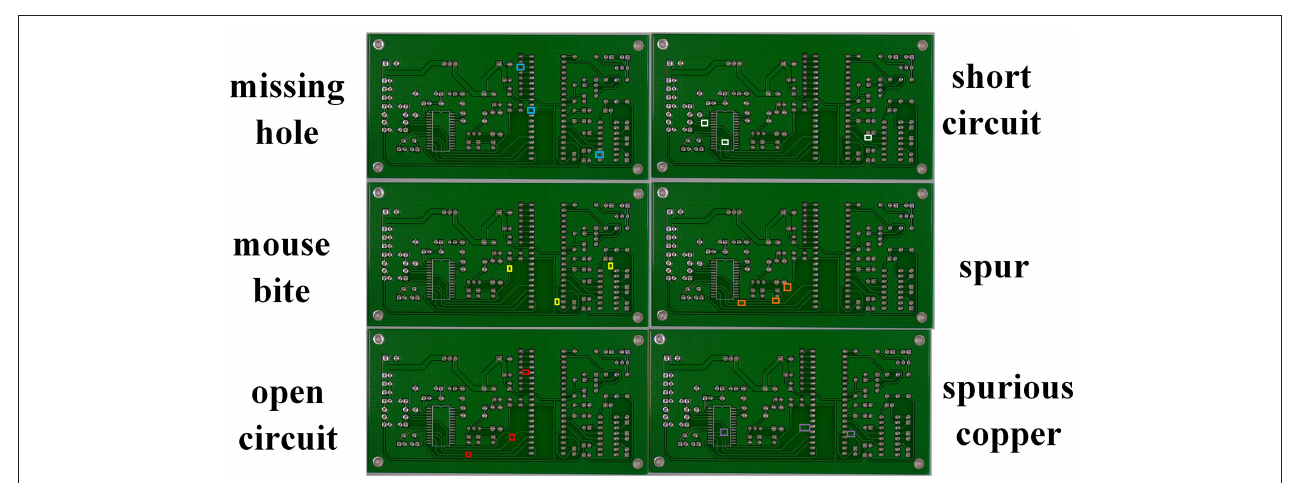
FIGURE 2 | Six kinds of minor defects on the surface of the printed circuit board.